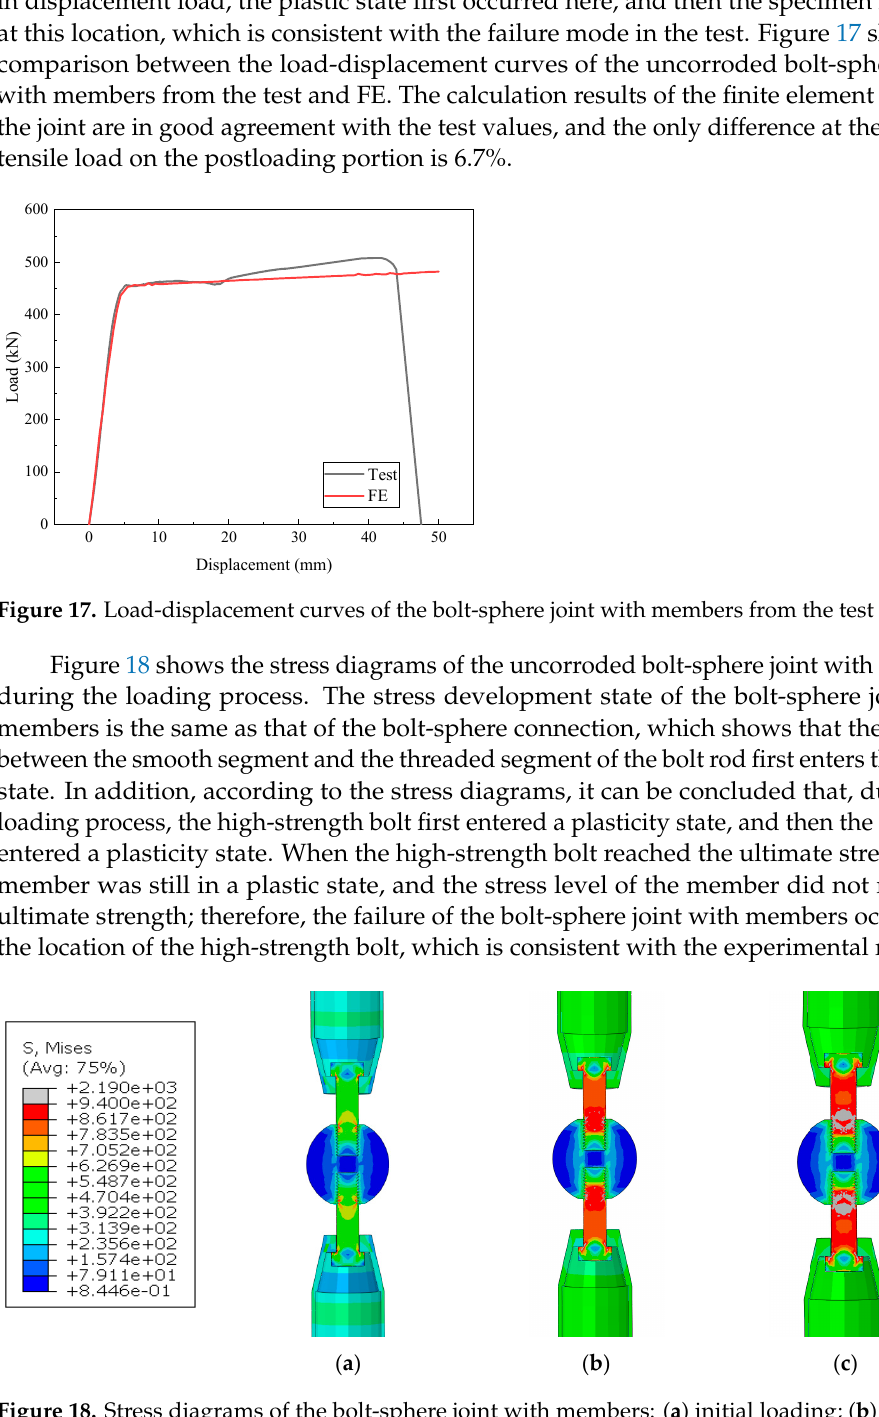
Displacement (mm) Test FE Figure 15. Load-displacement curves of the bolt-sphere connection from the test and FE. ( a ) ( b ) ( c ) Figure 16. Stress diagrams of the bolt-sphere connection: ( a ) initial loading; ( b ) mid-term loading; ( c ) postloading.